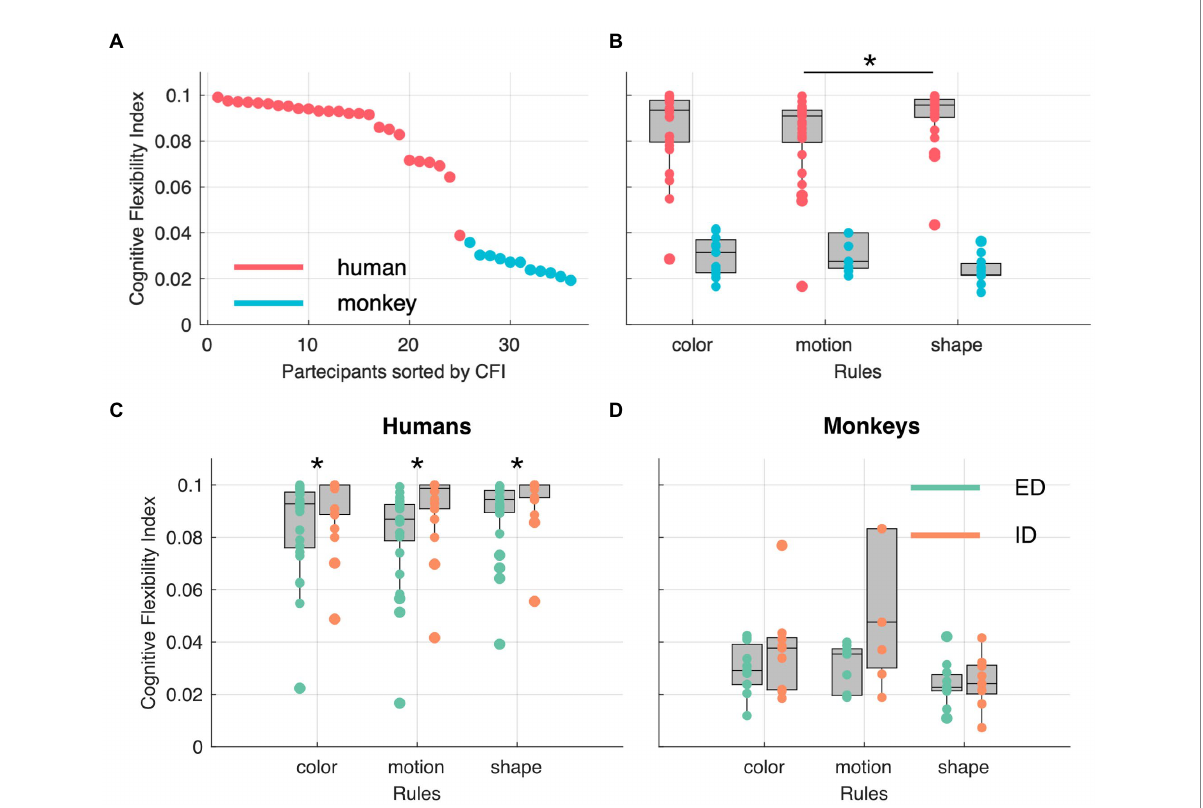
FIGURE 5 Participants sorted by cognitive flexibility index (CFI) across species (A) and rules (B) . Star indicates statistical significance at a paired Wilcoxon rank sum test, with an alpha level of 0.0083 (corrected for multiple comparisons). (C,D) show CFI as function of rules in intra-dimensional (ID) and extra-dimensional (ED) shifts. Stars indicate statistical significance at a Wilcoxon rank sum, non-paired, two-sided test.